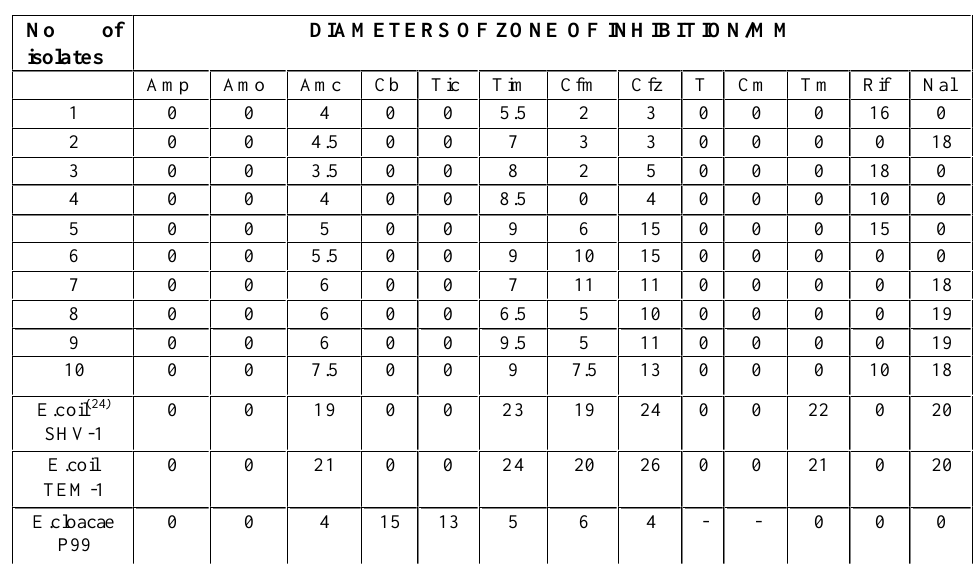
Table (3) Sensitivity Tests of Strains Determined by Disk Diffusion